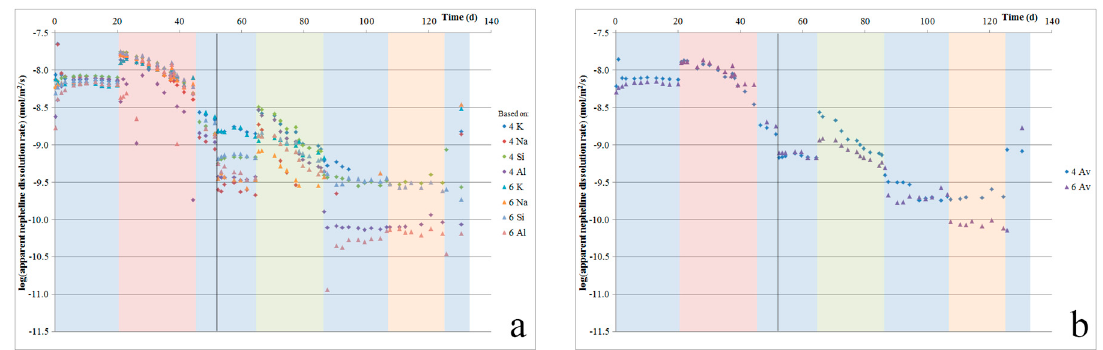
Figure 7. Apparent mineral dissolution rates for nepheline in nepheline syenite. Graph ( a ) shows the rates calculated per individual element released, while ( b ) shows the averaged rates per sample. Note the decline in dissolution rate starting after ~20 days.